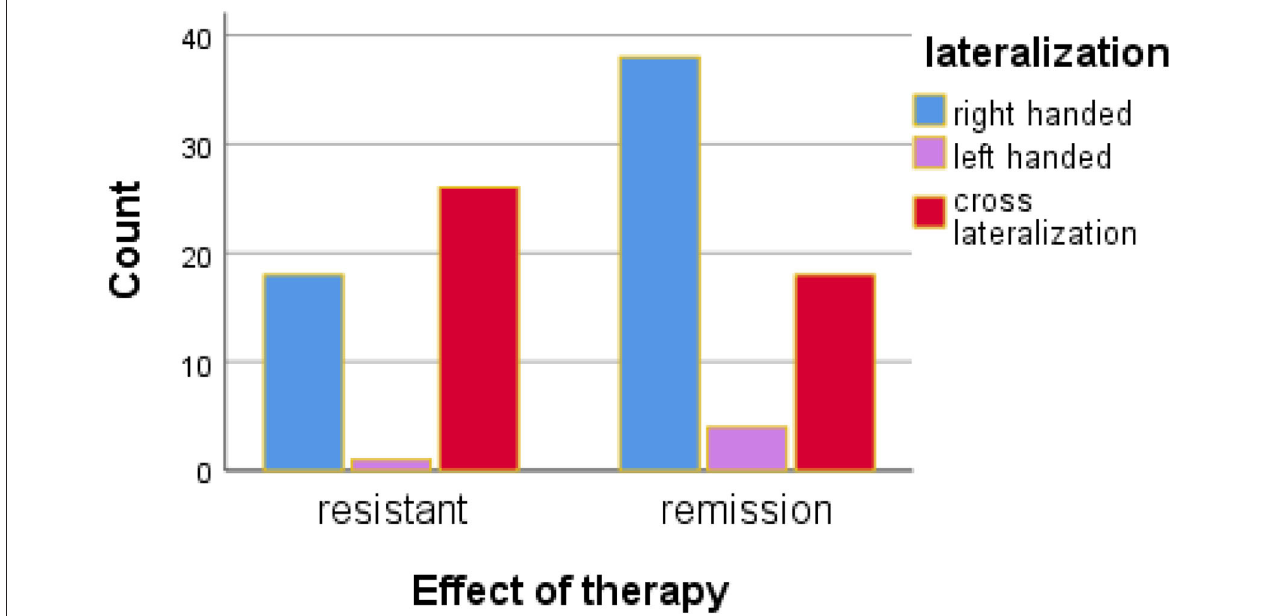
FIGURE 1 | The relationship between functional lateralization /pure and cros-dominance/ and treatment effectiveness.